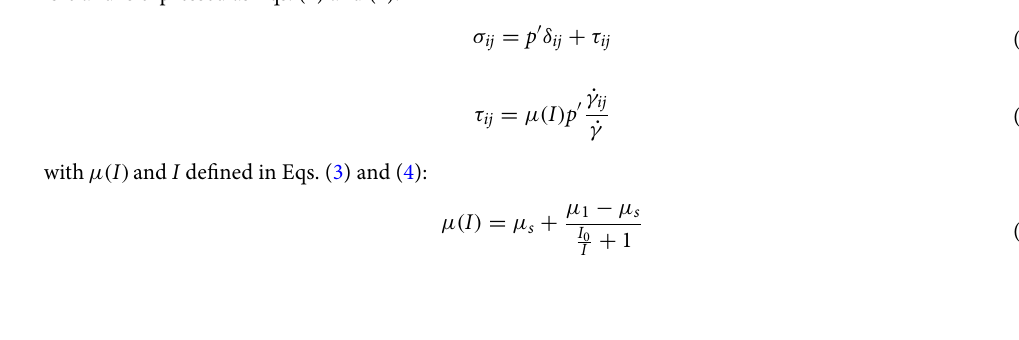
p ′ , γ gradually (cid:31) (cid:30)